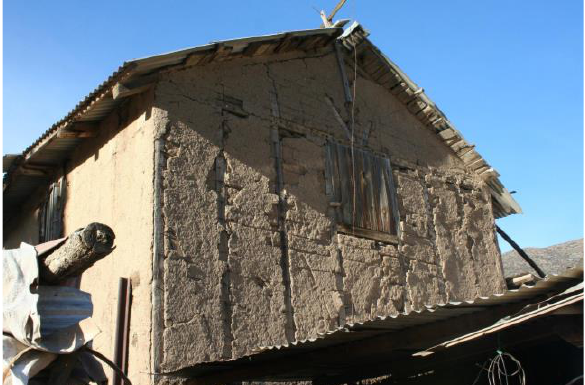
Figure 4. ‘Tabique ’ furnace in El Queñe with one horizontal block between the sawn wooden elements and horizontal wires.